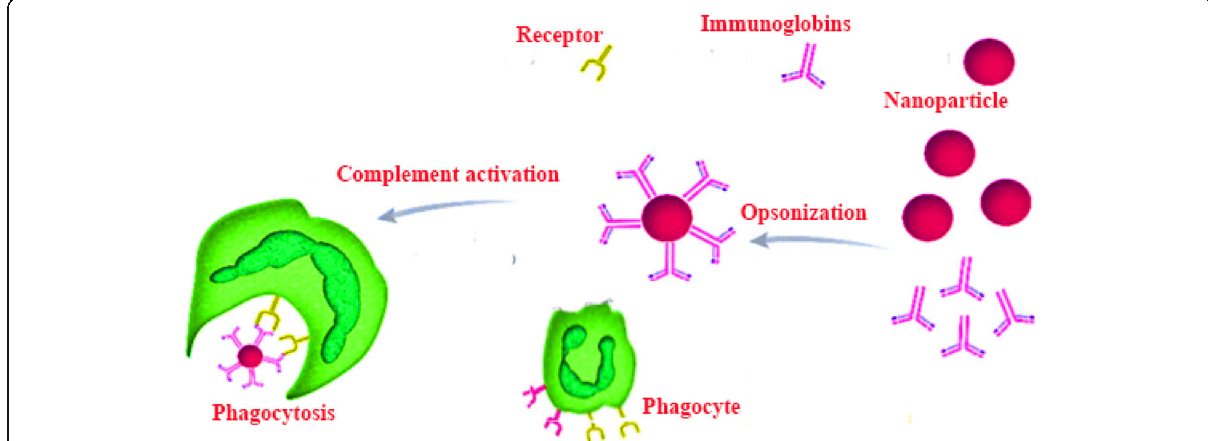
Fig. 8 Phagocytosis process of